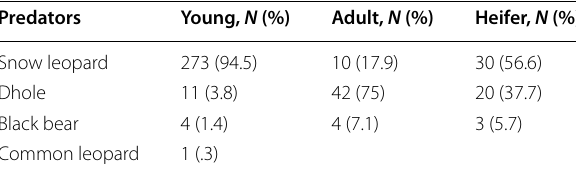
Table 3 Age category of yak depredation by wild predators